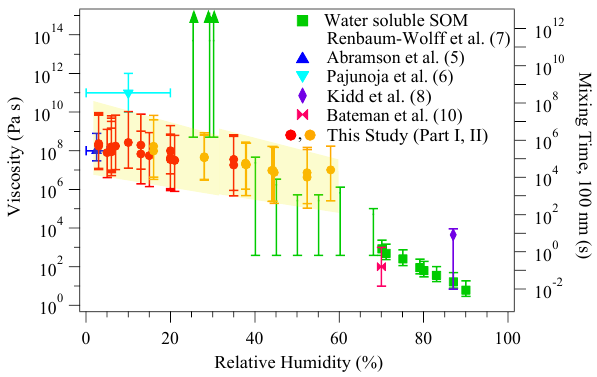
Figure 6. Summary of the RH-dependent viscosity obtained from this study for α -pinene secondary organic material for < 5 to 58%RH. The secondary y axis shows the mixing time of low volatility molecules with an 100-nm particle. Part 1 represents data for changes in the shape factor for residence time of 310s (cf. Fig. 4b). Part 2 represents data for 45s. The secondary y axis shows the characteristic mixing time τ of low-volatility organic molecules due to bulk diffusion in 100-nm particles of the same viscosity. Re- sults from literature are also plotted for comparison. A breakdown of the factors contributing to the uncertainty bars is presented in Fig. S13. Parts I and II also represent particle populations domi- nantly composed of dimer and trimer agglomerates,